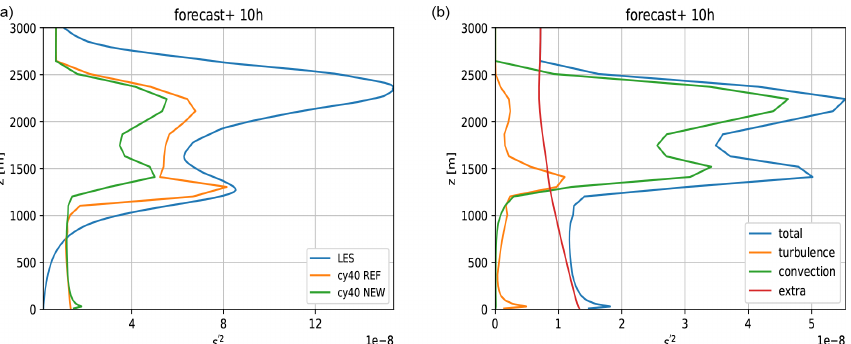
Figure 12. ARM case, 10th simulation hour. Panel (a) shows the profile of the variance in s in LES (blue), cy40REF (orange), and cy40NEW (green). Panel (b) shows the contribution of the turbulence (orange), convection (green), and the extra term (red) in Eq. (38) to the variance in s for cy40NEW.